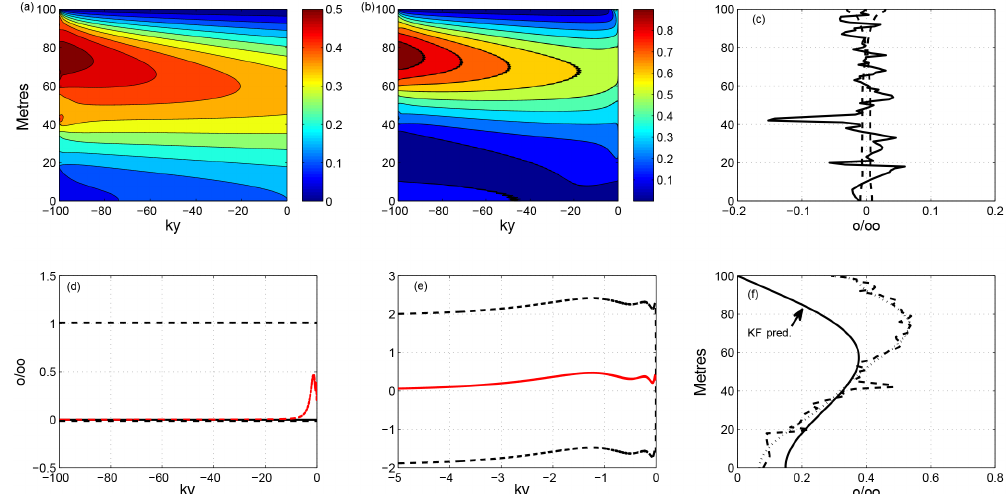
Figure 12. Core 1063 with a flat prior, quasi-periodic initial–final conditions, and with the terminal data uncertainty matrix R structured to emphasize the range of depths of the core maximum. Position and magnitude of the maximum are good. All other structures are then inferred to be a noise process. Compare Fig. 11.